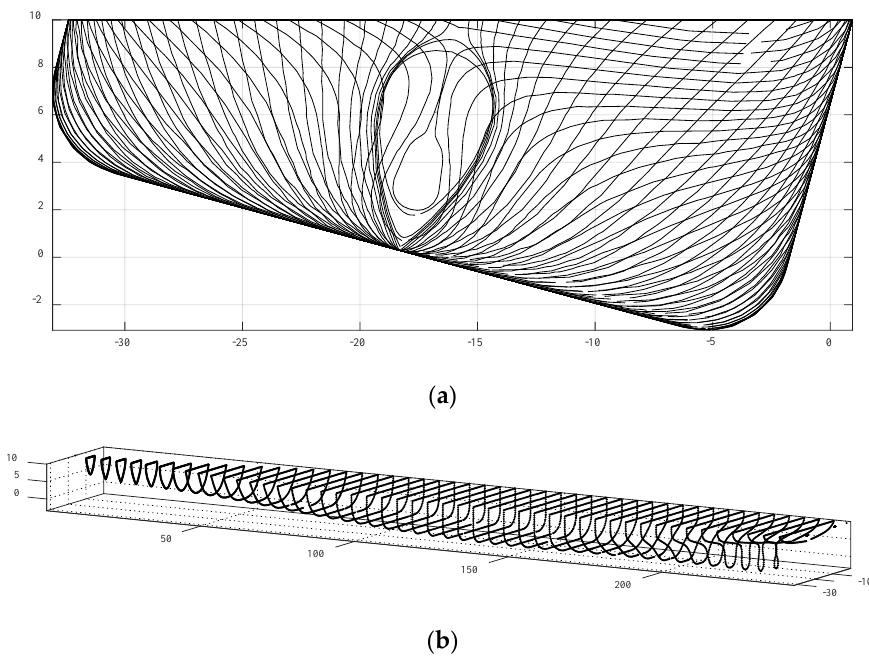
Figure 11. ( a ) Body plan under rolling (KCS, roll angle: 15°, 70 slices). ( b ) Body plan under pitching (KCS, pitch angle: 2°, 50 slices).